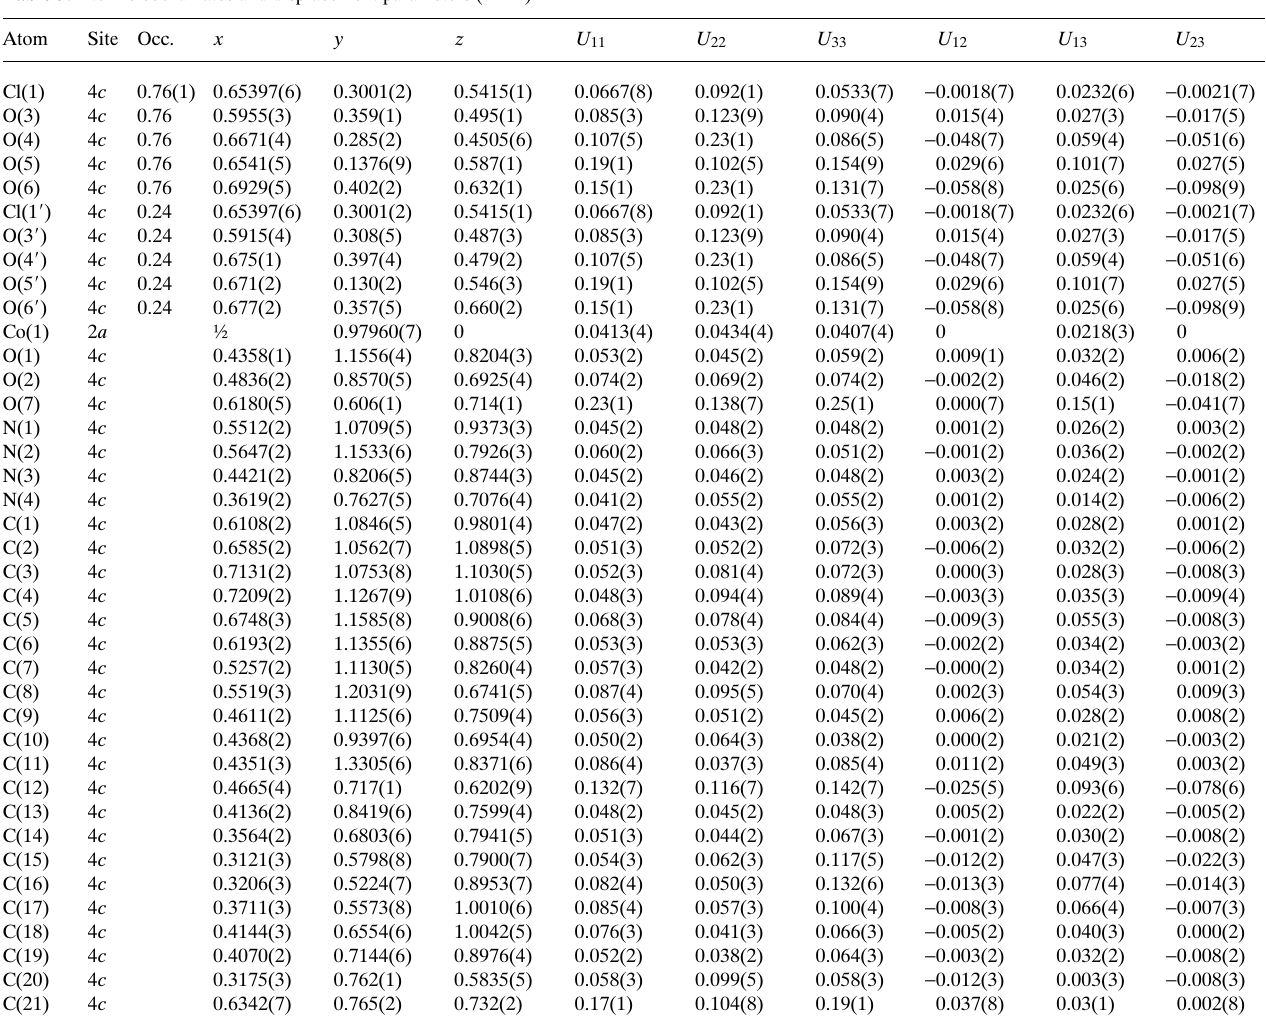
Table 3. Atomic coordinates and displacement parameters (in Å 2 ) .